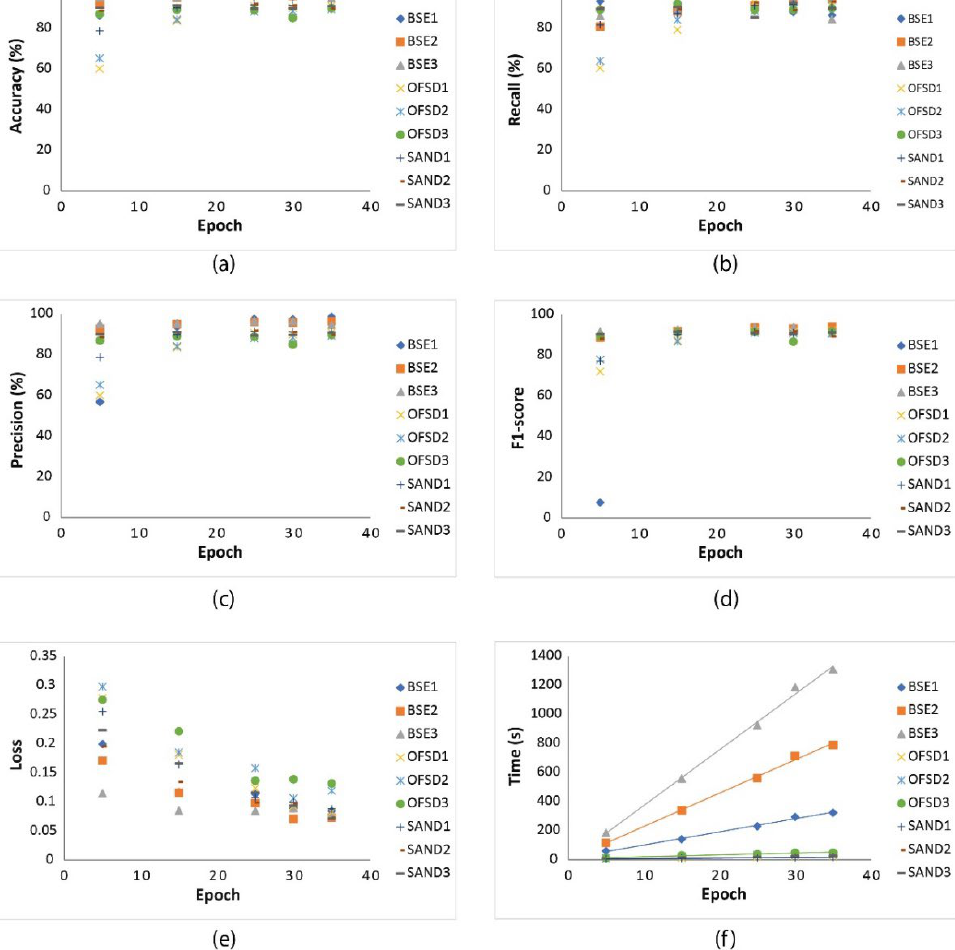
Table 2. Resultant time and performance for nine net models under an epoch of 30.